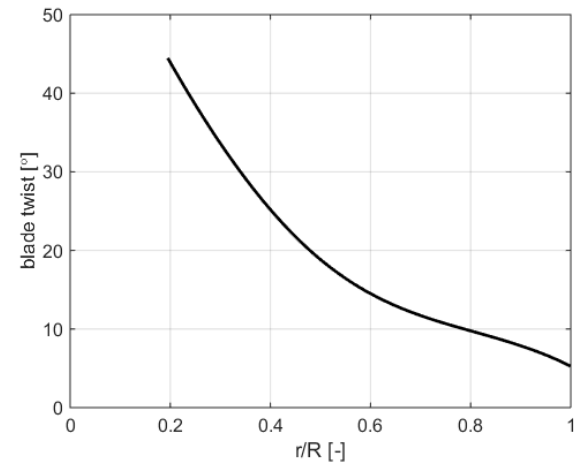
Figure 4. Propeller blade geometric twist distribution.